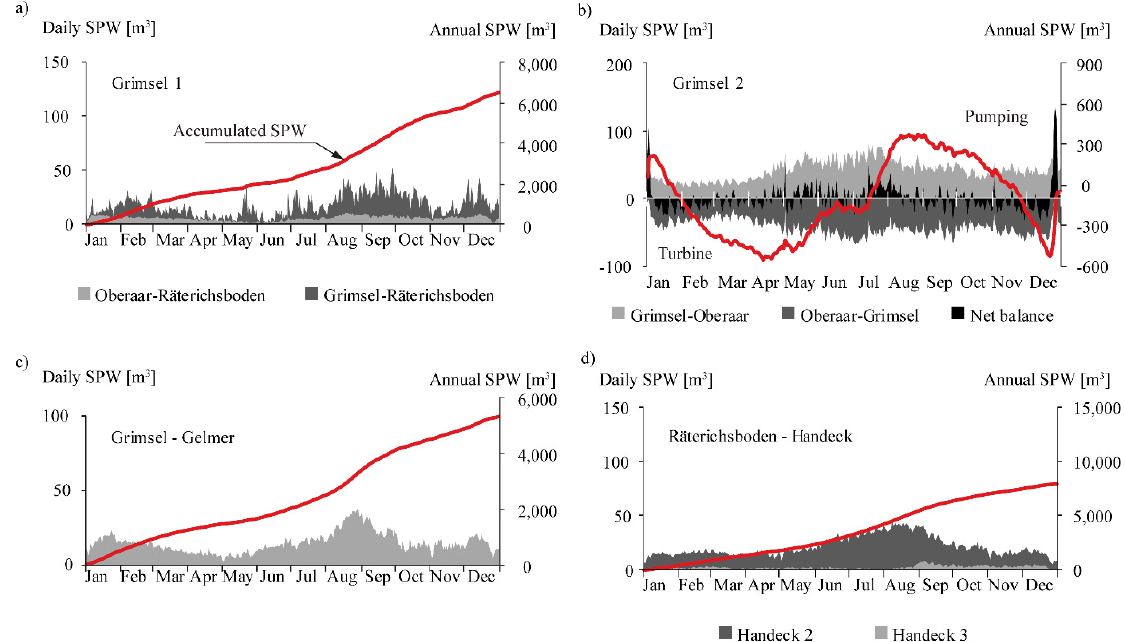
Figure 6. Daily values of SPW and accumulated values of SPW during an average year for: ( a ) Grimsel 1; ( b ) Grimsel 2; ( c ) Grimsel to Gelmer; and ( d ) Räterichsboden to Handeck.